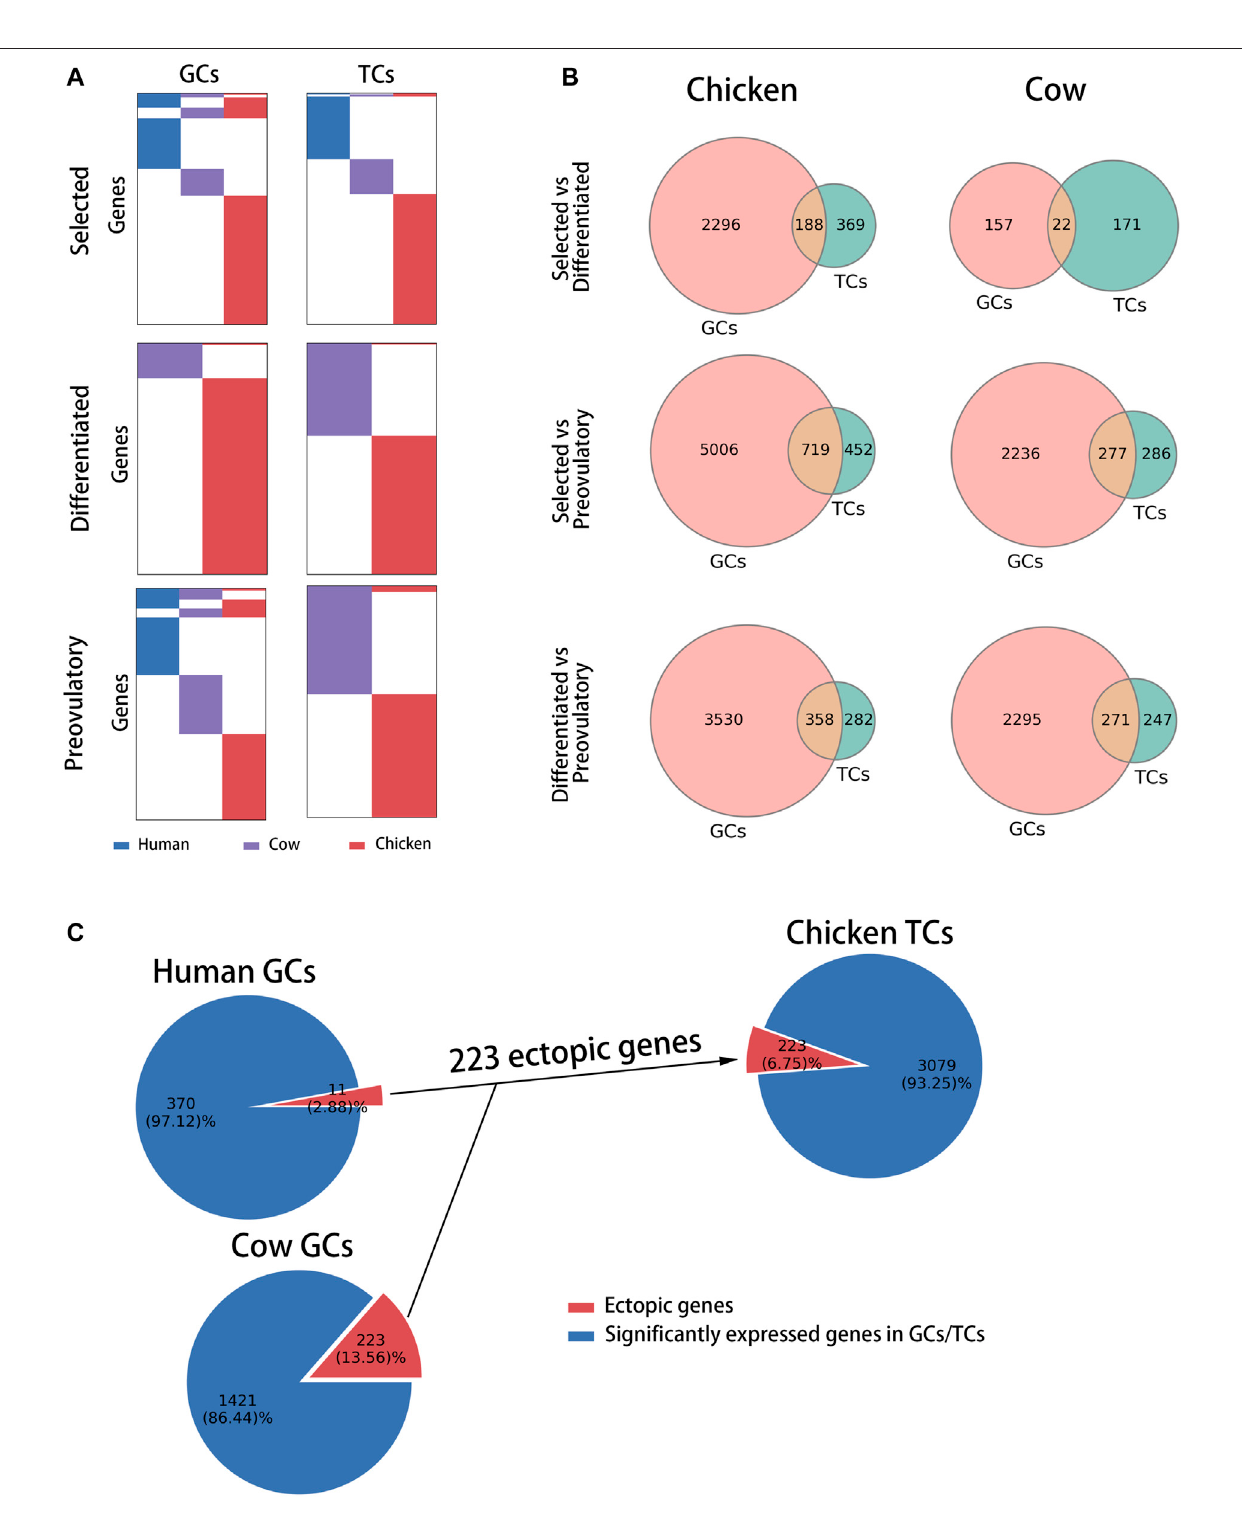
FIGURE 2| Comparison offollicle development-related genes among species at each stage offollicle development. (A) Distribution of follicle development-related genes (rows) among species (columns) at each stage in GCs and TCs. Human, cow and chicken genes are marked in blue, purple and red, respectively. (B) Venn diagram showing the distribution of follicle development-related genes between chickens and cows at each stage in GCs and TCs. (C) Pie charts showing the percentage of ectopically expressed genes (red) at each stage for each species.